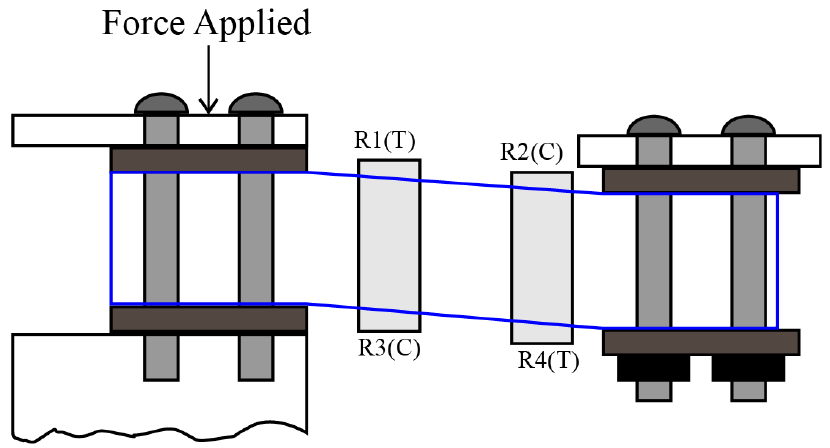
Figure 11. Force applied on z formation bar load cell.